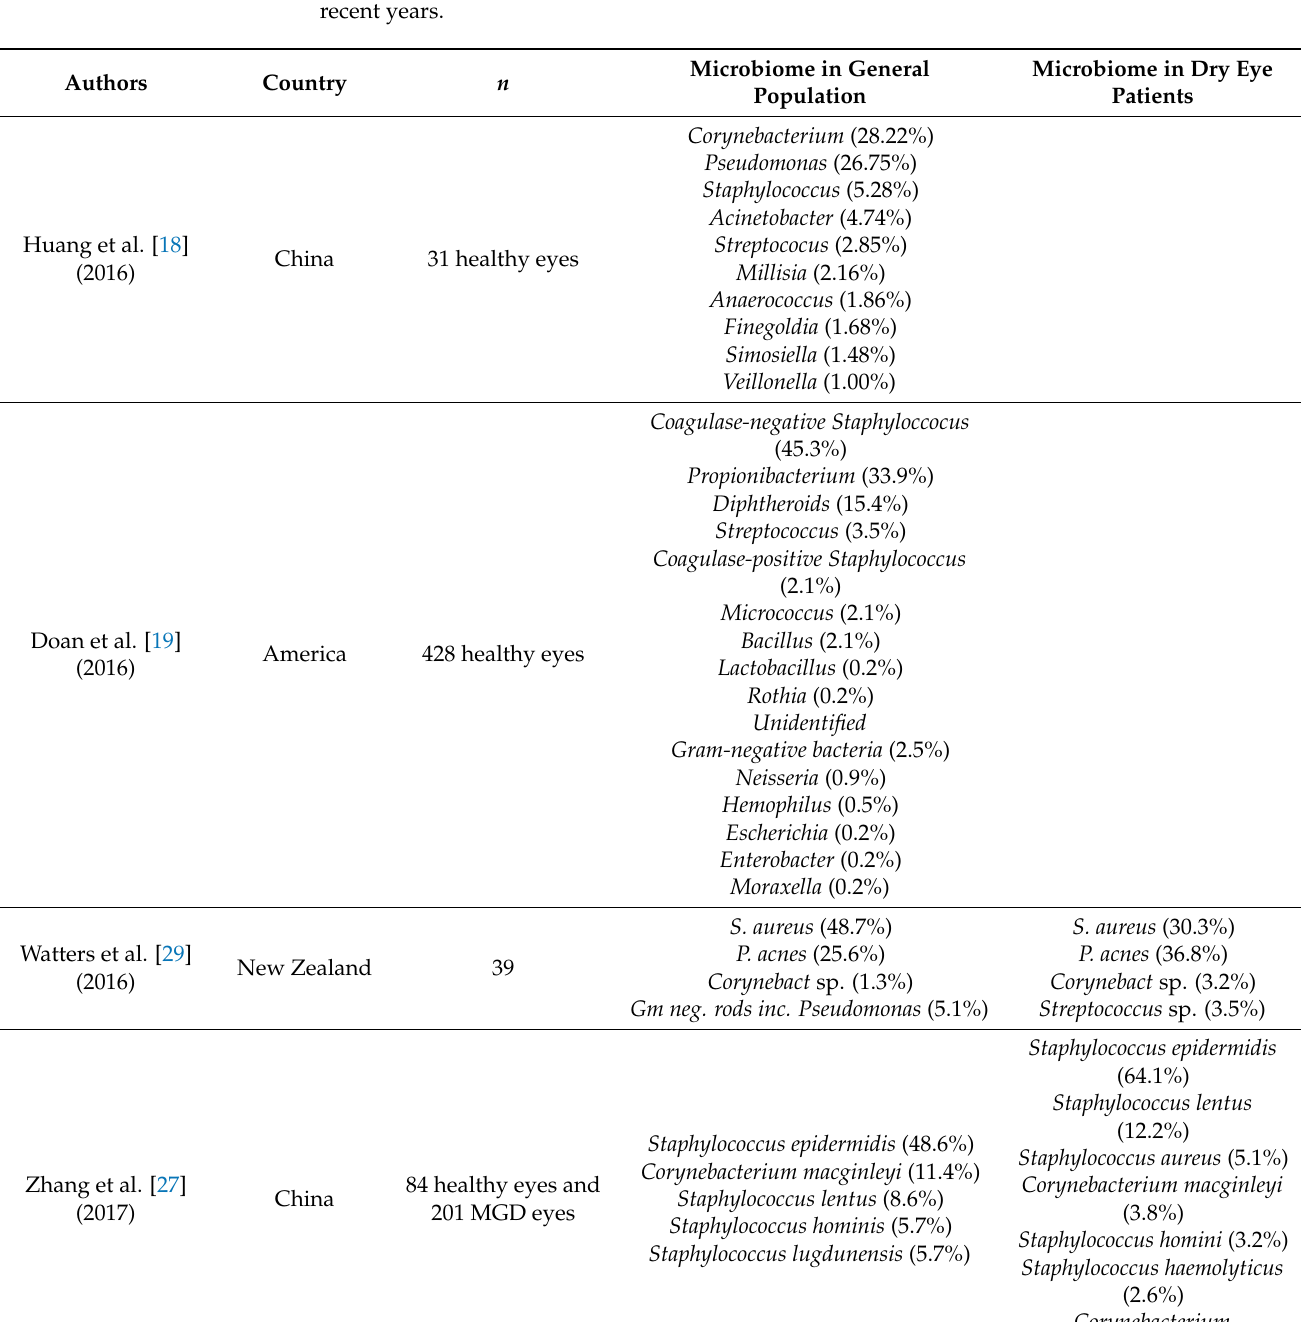
Table 1. Global comparison of the microbiomes of the general population and MGD population in recent